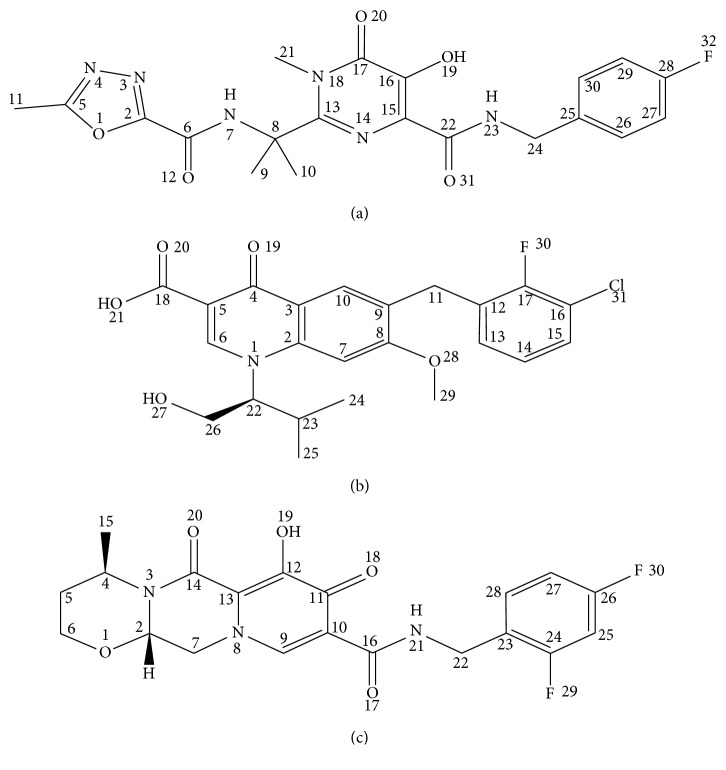
The structures of HIV-1 IN inhibitors. (a) Raltegravir, (b) elvitegravir, and (c) dolutegravir.